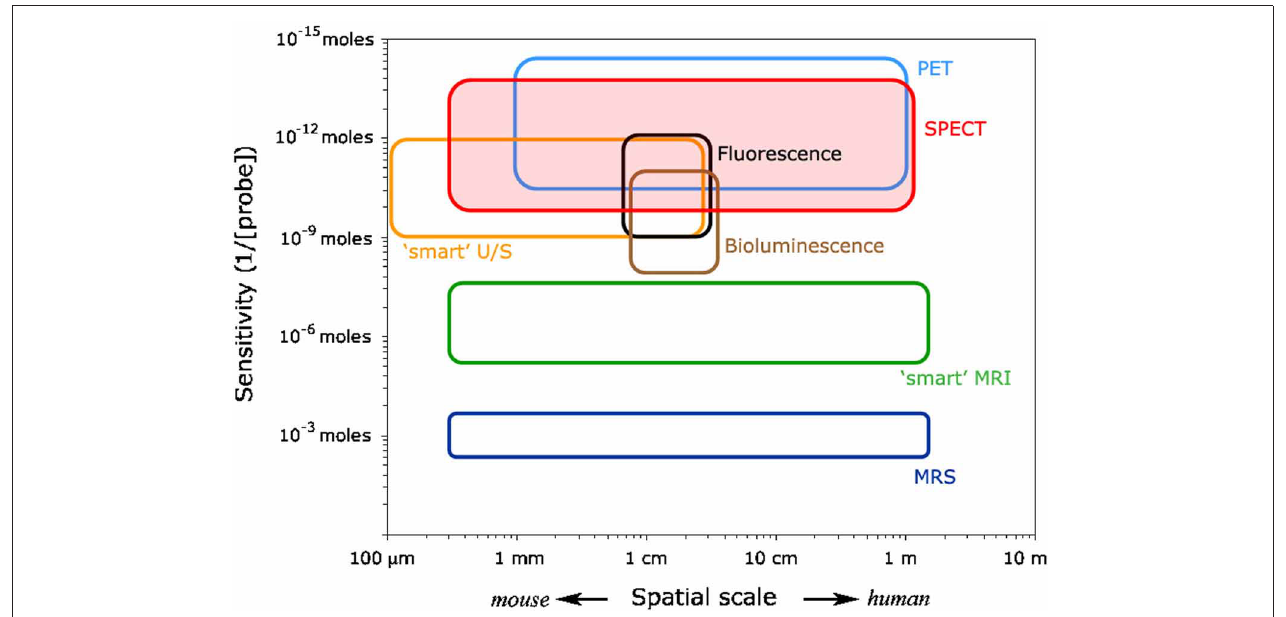
FIGURE 1 | Molecular imaging matrix indicating the relative position of various invasive and non-invasive imaging techniques (adopted from Meikle et al., 2005). Please note that the temporal resolution of the